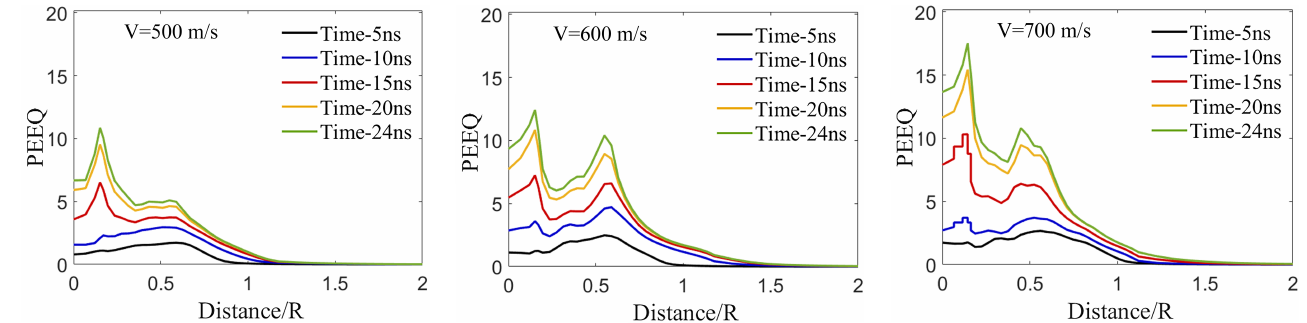
Figure 9. The time-evolved localized plastic deformation (PEEQ) over the contact-surface between the Al substrate and the B 4 C particle in the Al surface. The particle size is D Particle =15 µ m and impact velocities of 500, 600, and 700 m/s on the Al substrate without